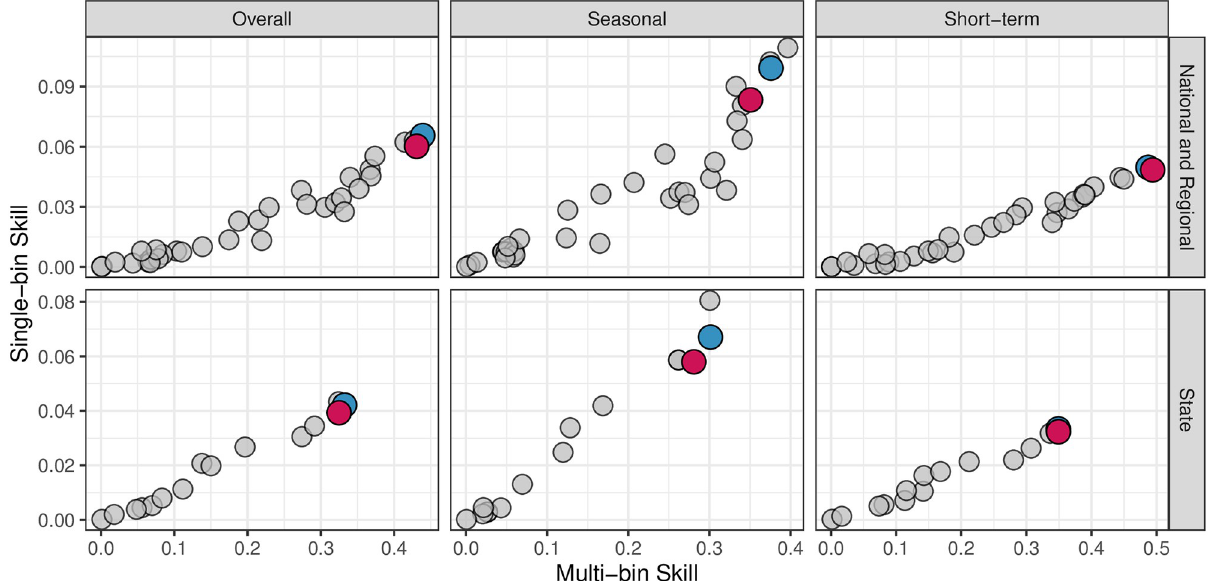
Fig 12. Results for the 2018/19 FluSight National and Regional challenge (top row) and State challenge (bottom row) for Inferno (red point), Dante (blue point) and all other models that participated in the 2018/19 FluSight challenges (grey points). The 2018/19 FluSight challenge evaluated models using multi-bin skill (x-axis), but starting with the FluSight 2019/20 challenge, will be using single-bin skill (y-axis). Skill scores are presented overall (left column), but also by seasonal targets (middle column) and short-term targets (right column). Inferno is a leading forecasting model overall, excelling in short-term forecasting, with good but not leading seasonal forecasting